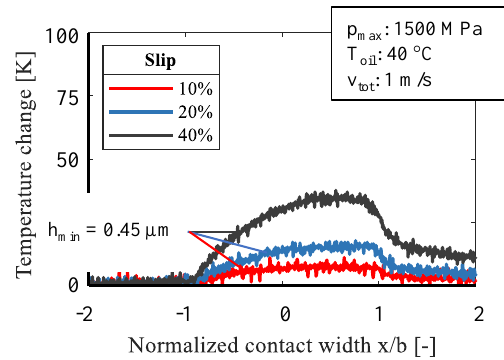
Figure 9. Comparison of slip at mixed friction.